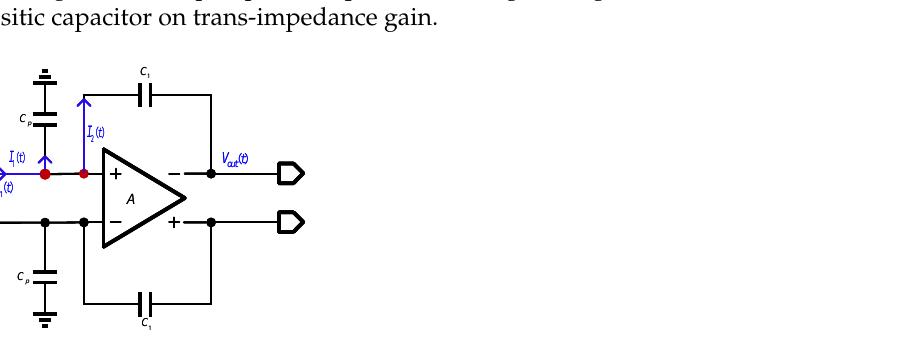
Figure 10. Schematic of the resistive feedback TIA describing the noise performance Compared with telescopic cascade and two-stage amplifier, folded cascade amplifier has a better trade-off in power consumption and output swing. In this design, we adopt the structure of folded cascade amplifier, and the diagram is shown in Figure 11. Compared